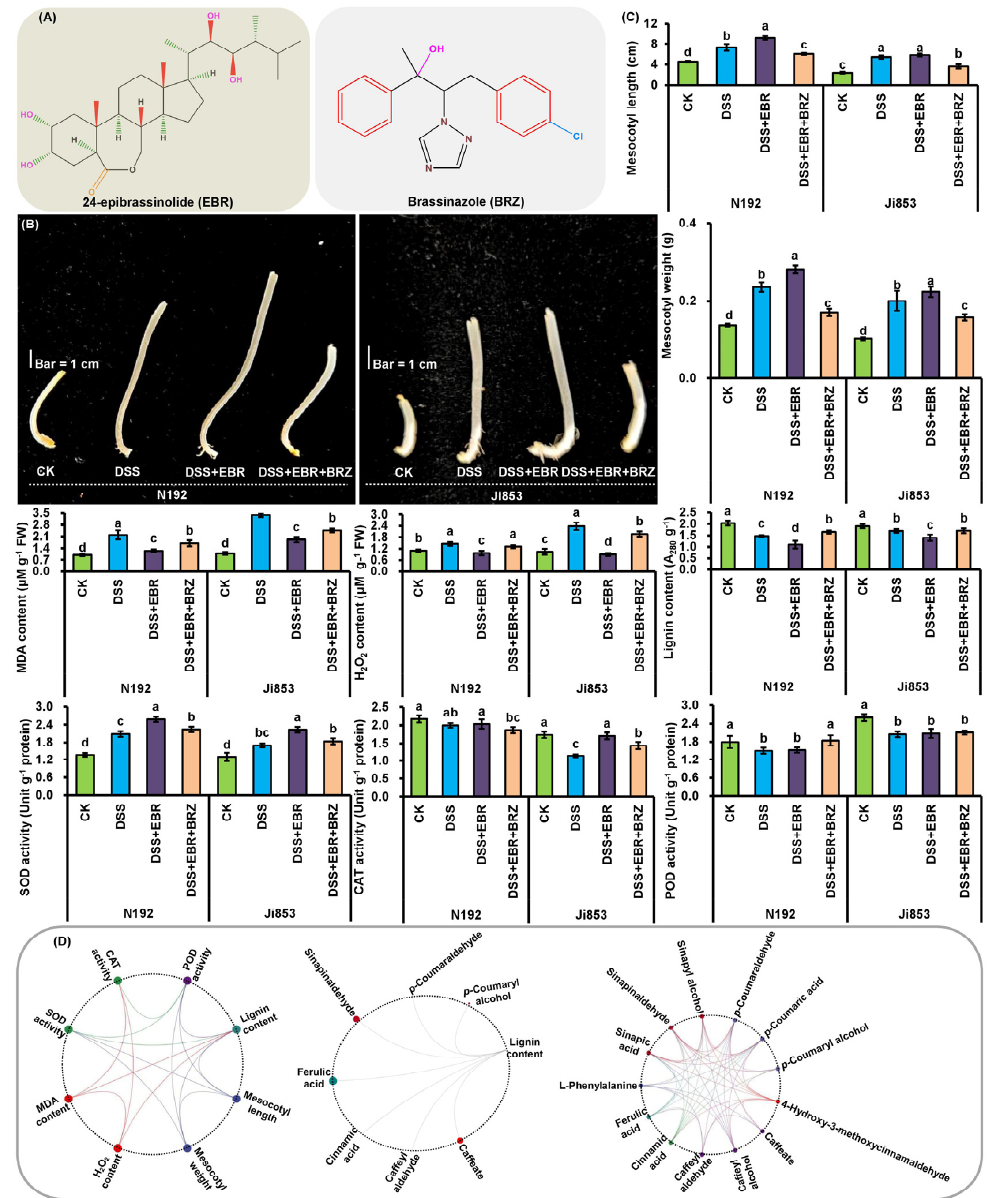
Figure 1. Growth, physiological characteristics, and their relationships of mesocotyls in two contrasting maize genotyes (N192 and Ji853) under 3 cm sowing depth (CK), 20 cm sowing depth (DSS), 4.16 × 10 − 3 M 24-epibrassinolide (EBR) induction at 20 cm sowing depth (DSS + EBR), 4.16 × 10 − 3 M EBR and 3.05 × 10 − 3 μ M brassinazole (BRZ) induction at 20 cm sowing depth (DSS + EBR + BRZ). EBR and BRZ structures ( A ). Mesocotyls observation in N192 and Ji853 under four conditions ( B ). Statistics of mesocotyl length (MESL), mesocotyl weight (MESW), malondialdehyde (MDA) content, H 2 O 2 content, lignin content, SOD activity, CAT activity, and POD activity of mesocotyls in N192 and Ji853 under these conditions. Different lowercase letters with a single maize genotype among four conditions represented significant differences with p < 0.05 level ( C ). Interactive ring correlation plot of these traits in both maize genotypes under three conditions (CK, DSS, and DSS + EBR) was performed by a free online Genescloud tool (https://www.genescloud.cn; accessed on 10 December 2021). The connection curve in both traits showed a significant positive or negative correlation in p < 0.05 level ( D